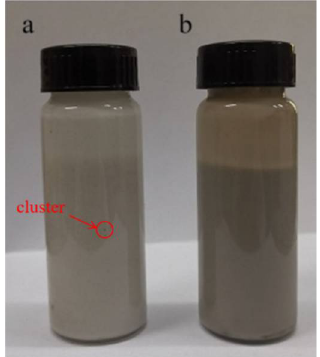
Figure 2. ( a ) GO mixed PVDF-g-SSS membrane solution, ( b ) GO-SSS mixed with PVDF-g-SSS membrane solution at the same concentration of 0.5%.